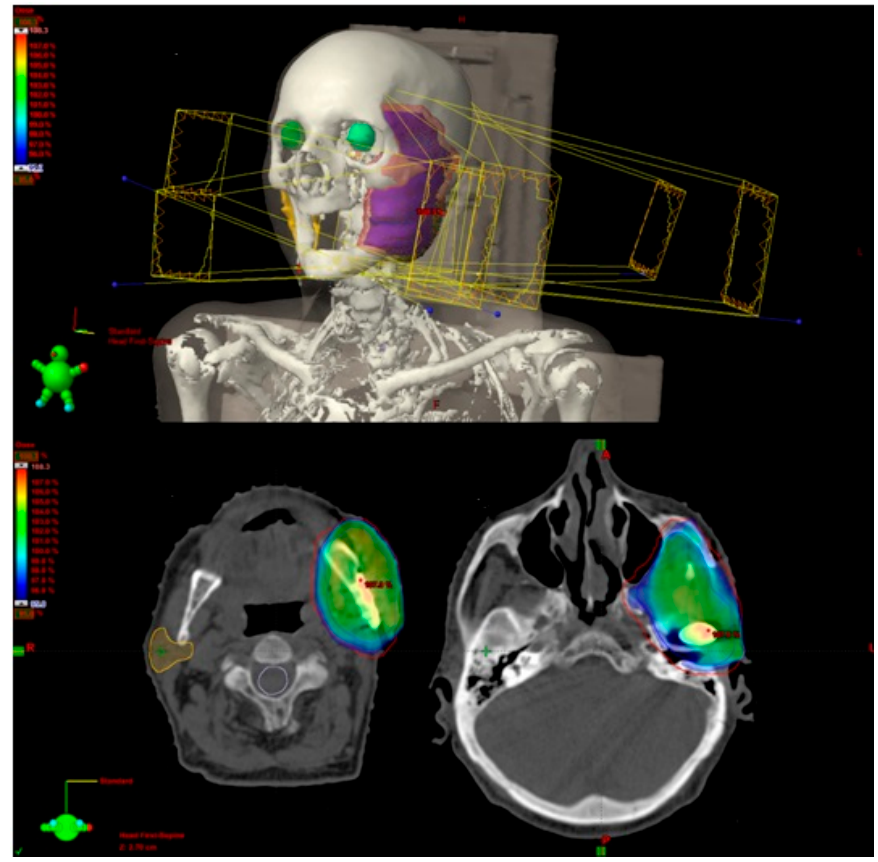
Figure 7. Radiotherapy planning.